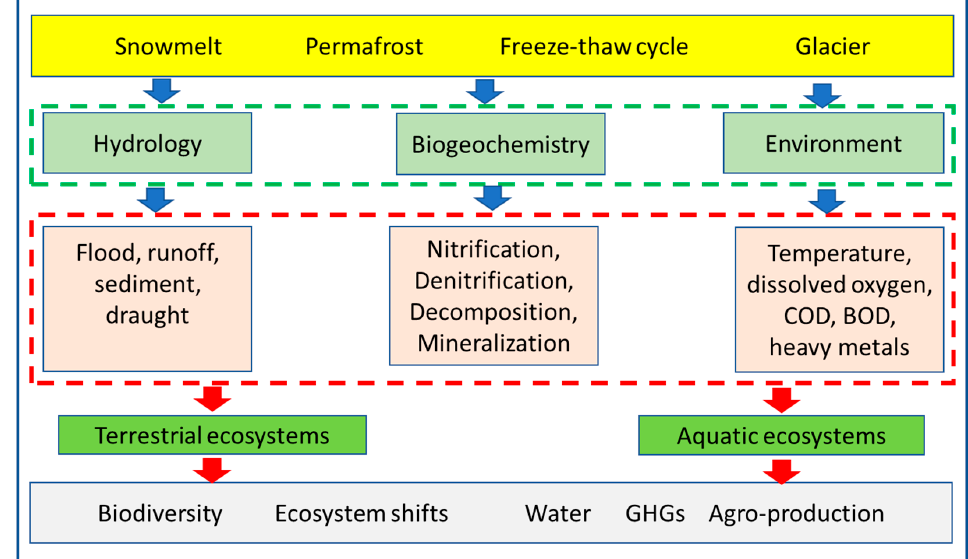
Figure 2. Effects of snow and ice processes on hydrology, biogeochemistry, and ecosystems.